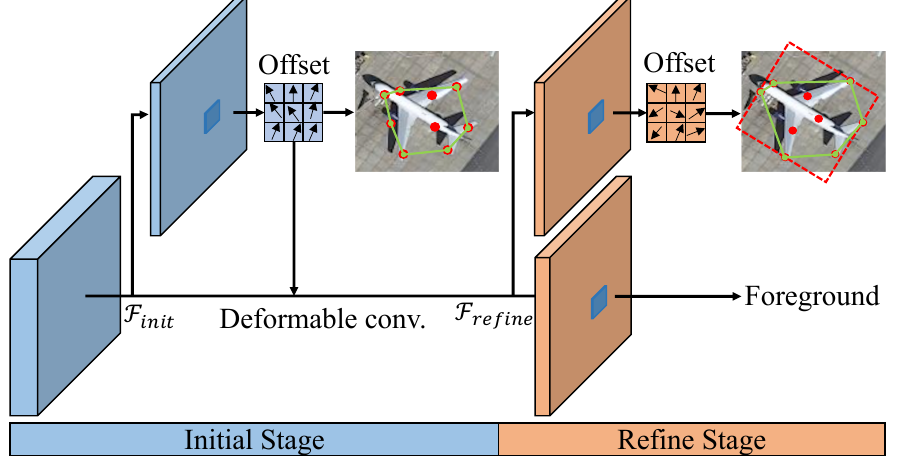
Figure 6. The structure of the proposed PointRPN. The red points are the learned representative points, and the green polygon represents the converted convex-hull. The red dotted OBB is converted from the representative points with the MinAreaRect function of OpenCV [28] for generating